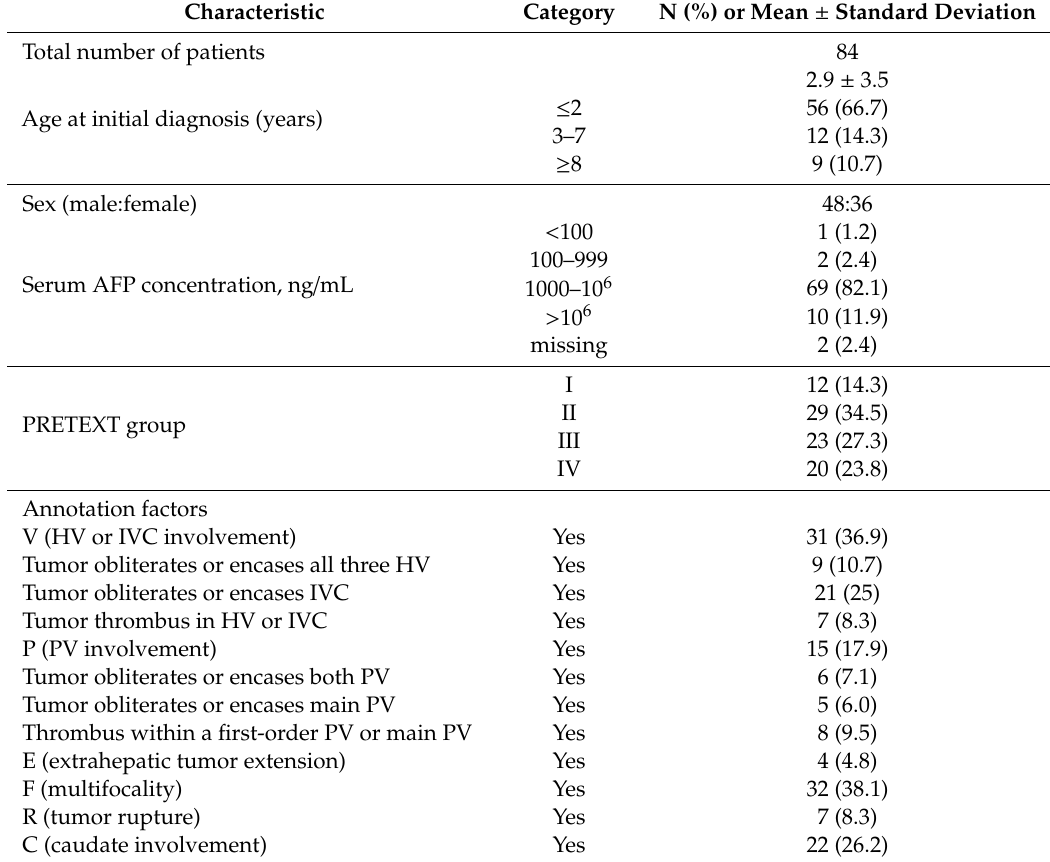
Table 1. Baseline patient and tumor